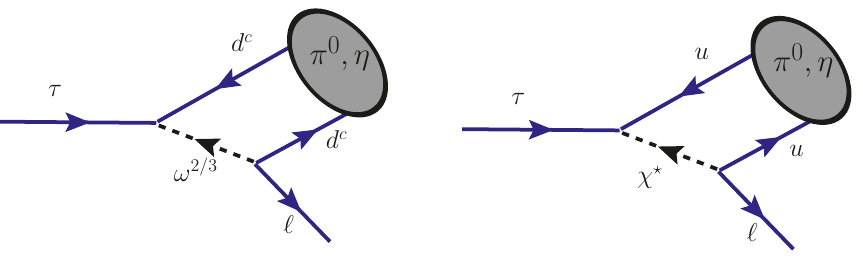
Figure 26 . Feynman diagram for (cid:28)